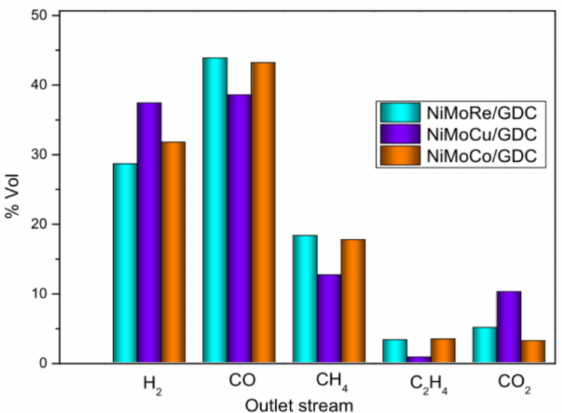
Figure 8. Comparison of products distribution of ATR reaction catalyzed by different catalysts, after 10 h, 120,000 h − 1 space velocity, and 800 ◦ C.